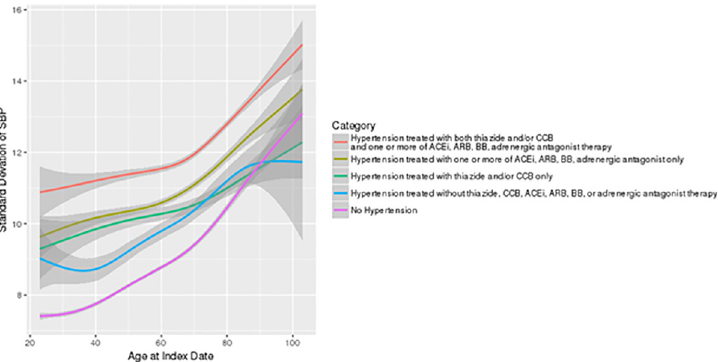
Fig 2. Average standard deviations between visits for systolic blood pressure in patients with vs. without hypertension, by age and drug treatment. Red: Hypertension treated with both thiazide and/or CCB and one or more of ACEi, ARB, BB, adrenergic antagonist therapy. Gold: Hypertension treated with one or more of ACEi, ARB, BB, adrenergic antagonist only. Green: Hypertension treated with thiazide and/or CCB only. Blue: Hypertension treated without thiazide, CCB, ACEi, ARB, BB, or adrenergic antagonist therapy. Purple: No Hypertension.